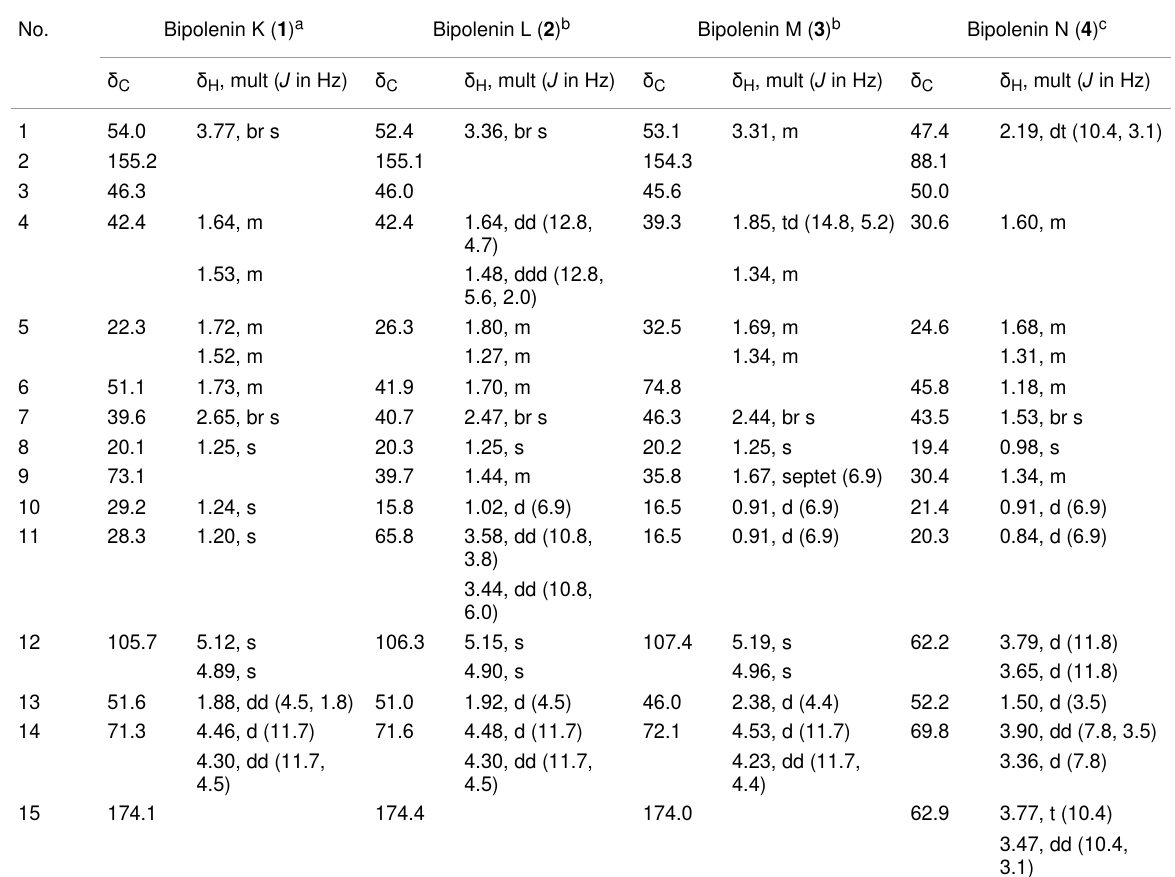
Table 1: 1 H and 13 C NMR data for bipolenins K–N ( 1 – 4 ). No.